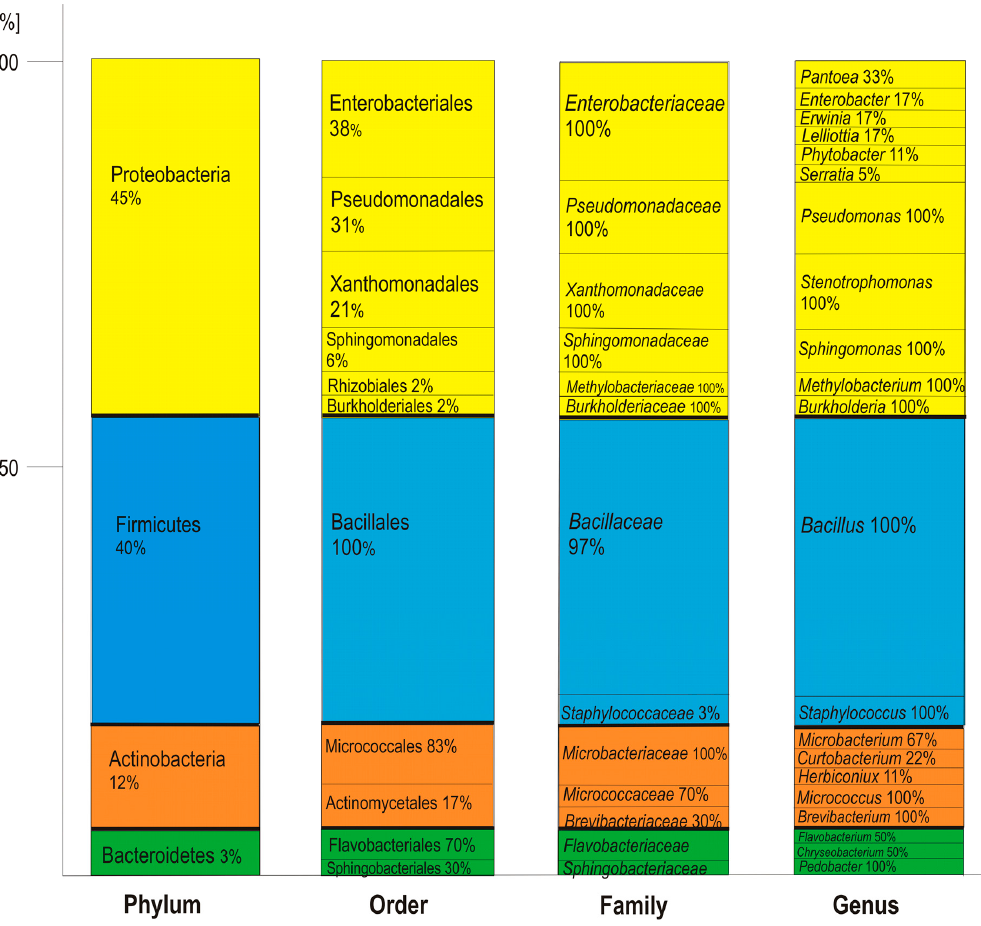
Figure 2. Percentages of in total 113 studied bacterial strains, identified on the basis of 16S rRNA gene sequences, in the main taxonomic groups.